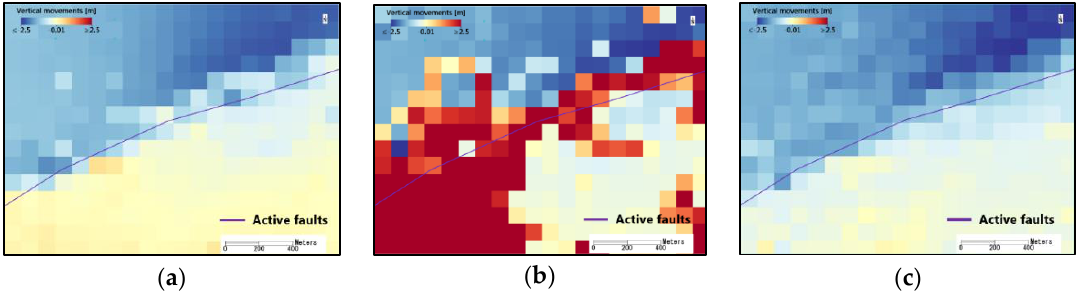
Figure 5. The estimated vertical coseismic displacements using averaged vertical differences in a 100 m 2 window: ( a ) The result of DSMs on 15 and 23 April 2016; ( b , c ) the result of the DSMs and DTMs acquired on 15 May 2006, and 8 May 2016.